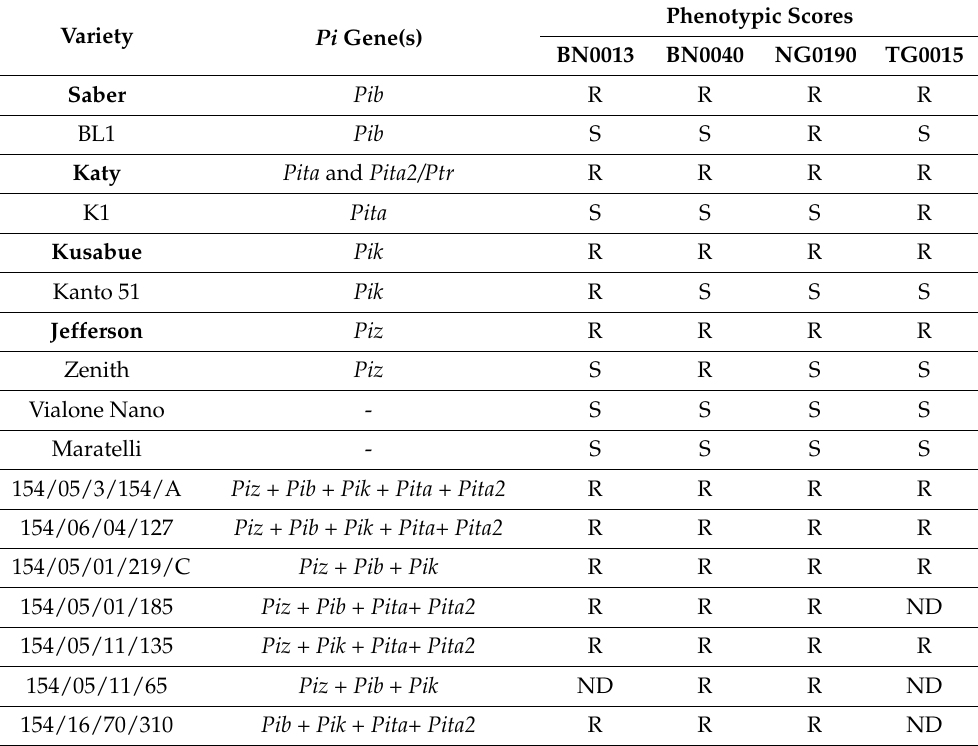
Table 4. Screening of resistance to 4 multivirulent strains of P. oryzae . The original donors of the Pi genes are in bold. ND = not determined, because most of the plants were resistant in most of the experiments but a few lesions were observed in at least one replicate. Variety Pi